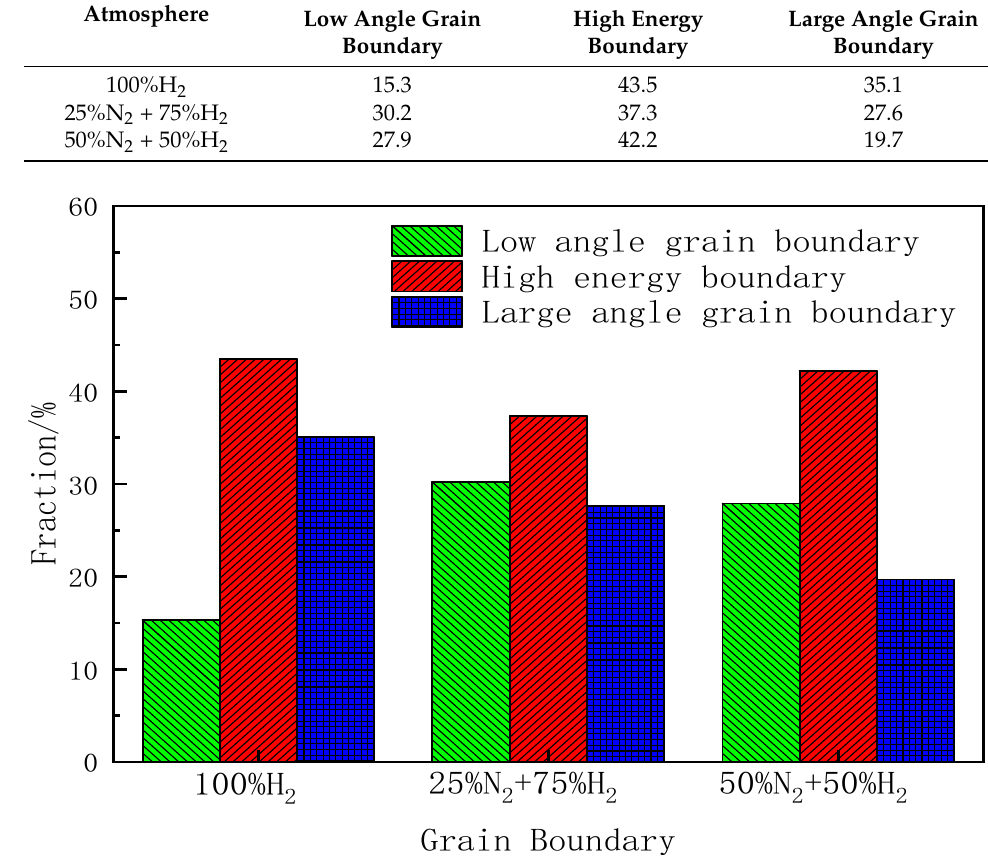
Figure 9. Grain boundaries content of finally annealed samples in different annealing